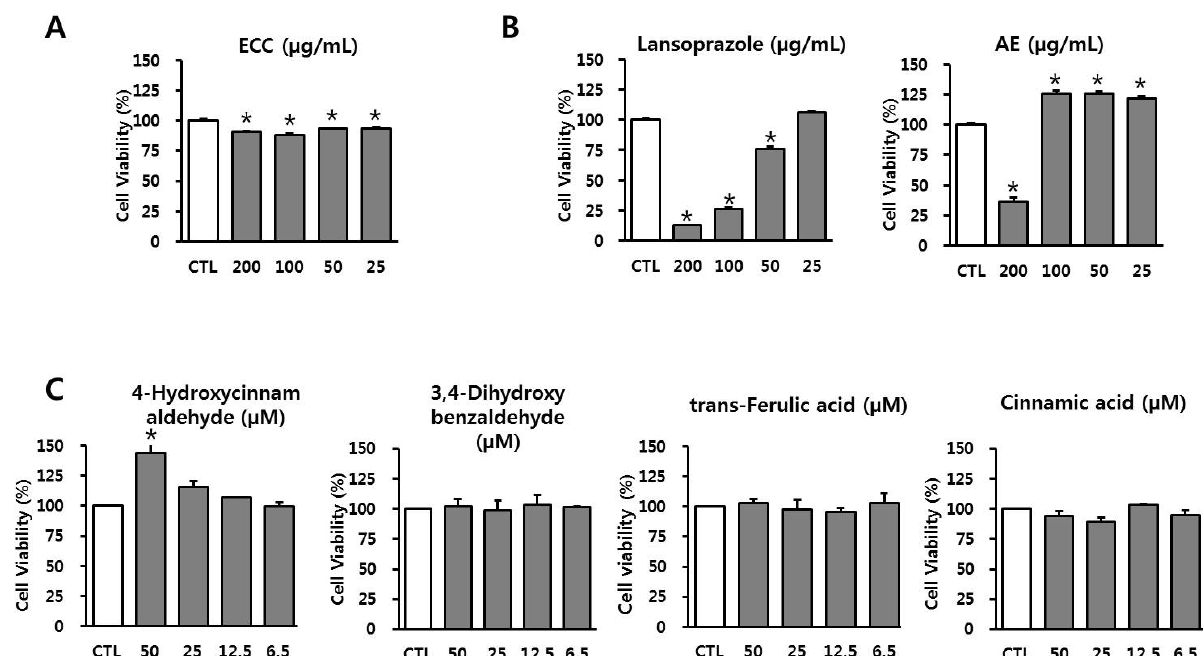
Figure 2. Effect of Cinnamomum cassia extract and its components on the viability of RAW 264.7 cells. ( A ) Effect of ECC on cell viability. ( B ) Effects of lansoprazole and Artemisia extract (AE) on cell viability. ( C ) Effects of ECC components on cell viability. RAW 264.7 cells were treated with different concentrations of ECC and its components for 24 h. Cell viability was determined using an EZ-Cytox assay as described in the Materials and Methods. The data are expressed as the means ± SD ( n = 3). * p < 0.05 compared to the control group.